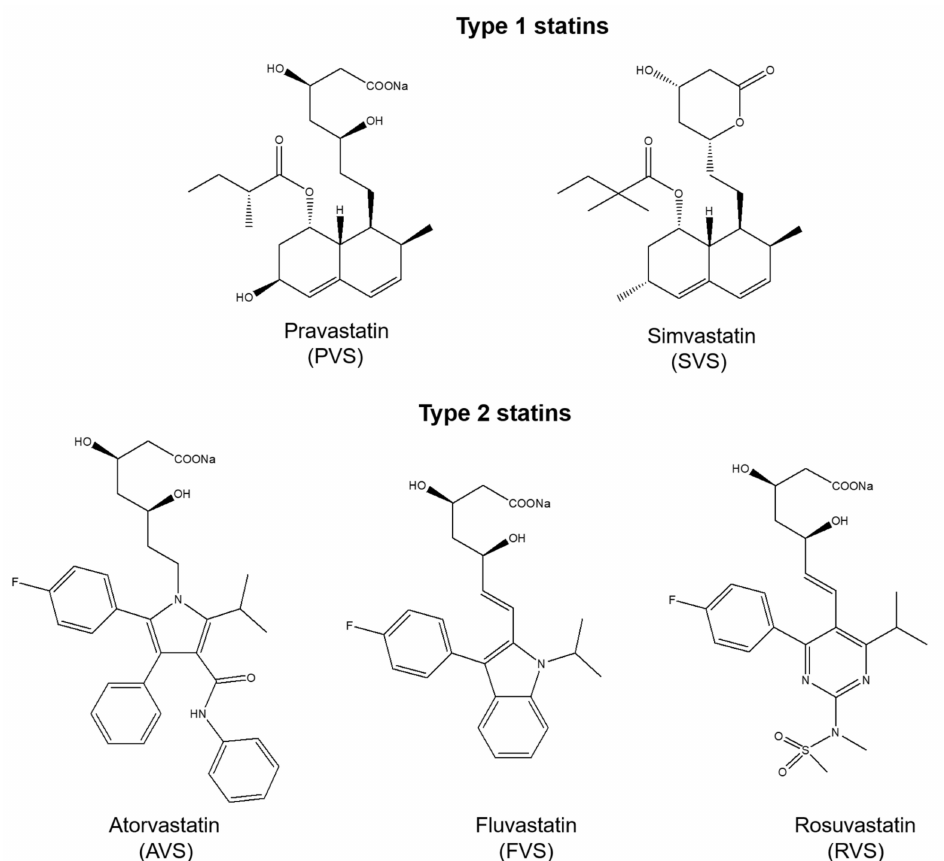
Figure 1. Chemical structures of statins used in the